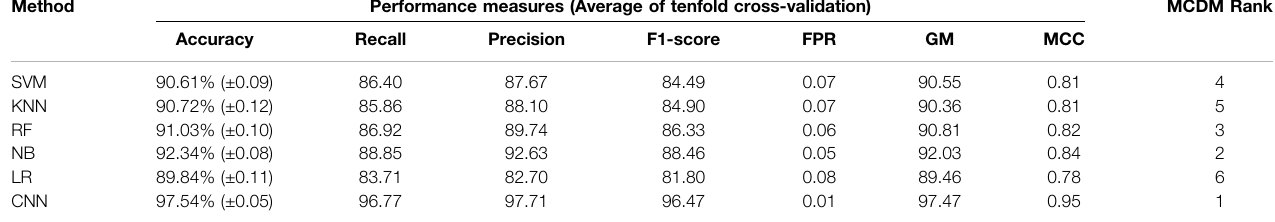
TABLE 3 | Models performance and ranking for methylation data. Method